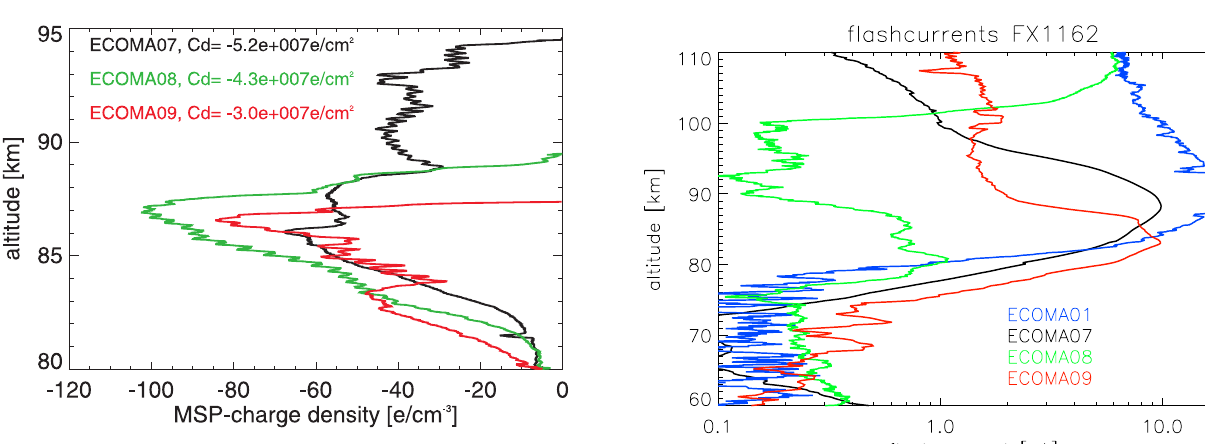
Fig. 6. Overview of all measurements of negatively charged me- teor smoke particles during ECOMA-2010. The legend identifies the three different rocket flights (see Table 1) and further states the negative charge column density (Cd) observed in each flight.